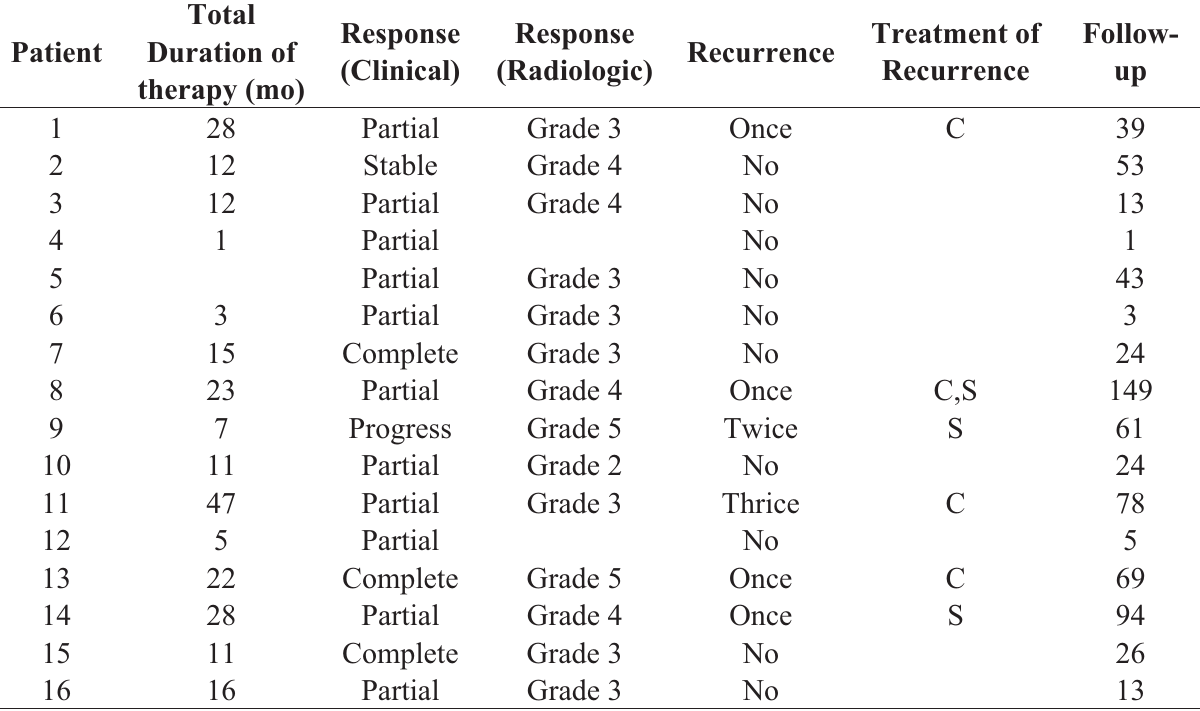
Table 2. Duration and response to therapy, recurrence, treatment of recurrence and length of follow-up for patients receiving chemotherapy for treatment of fibromatosis in the present